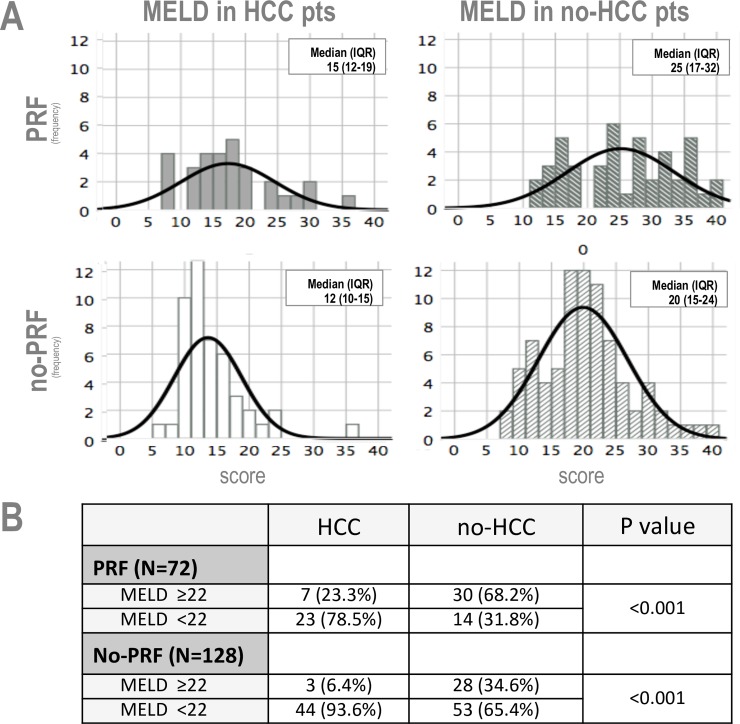
Frequencies of MELD in no-HCC and HCC patients.(A) Histograms of MELD according to the outcome (PRF vs no-PRF) are reported. For each subset mean ± SD and median (IQR) are reported. (B) Frequencies and (percentages) are reported in PRF and no-PRF patients according to MELD ≥22 and MELD <22.